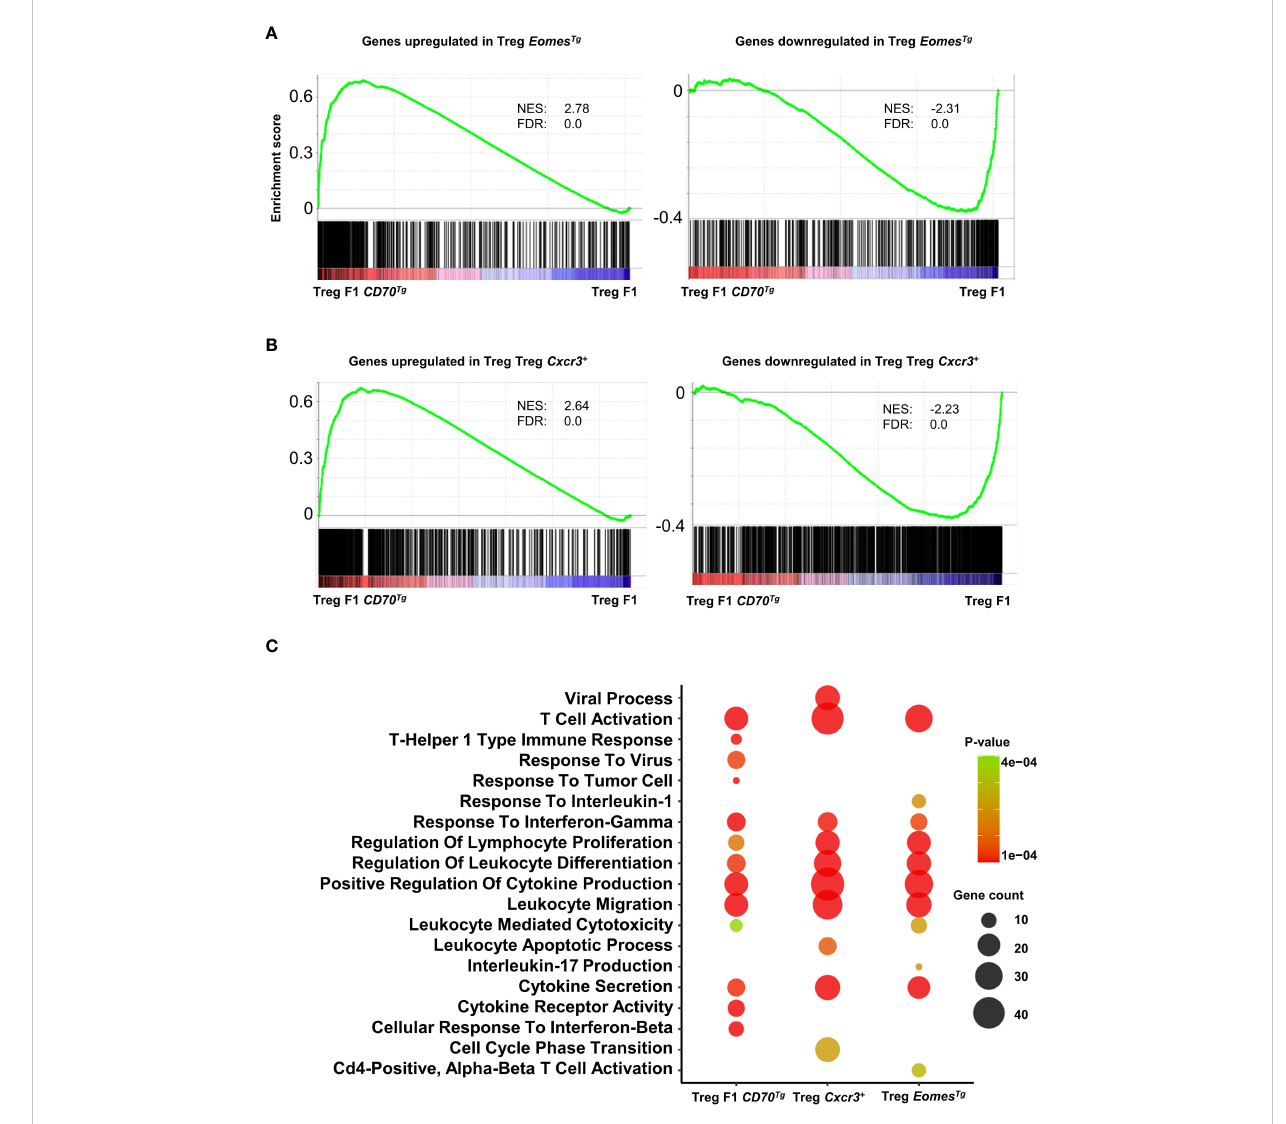
FIGURE 7 Common enriched pathways in Tregs from CD11c- Cd70 tg;CD27 +/- , Eomes Tg and CXCR3 + Tregs. (A, B) GSEA performed on F1 CD70 Tg data set and Treg Eomes Tg (A) or Treg Cxcr3 + (B) differentially expressed genes as gene sets. Normalized enrichment score (NES) and false discovery rate (FDR) are indicated. (C) Bubble plot for selected pathways (database MsigDB; https://www.gsea-msigdb.org/gsea/msigdb/) enriched from genes upregulated in Treg F1 CD70 Tg , Treg Cxcr3 + and Treg Eomes Tg using clusterPro fi ler R package with default parameters and presented as − Log 10 of p-value. Color intensity indicates p-value and bubble size indicates number of enriched